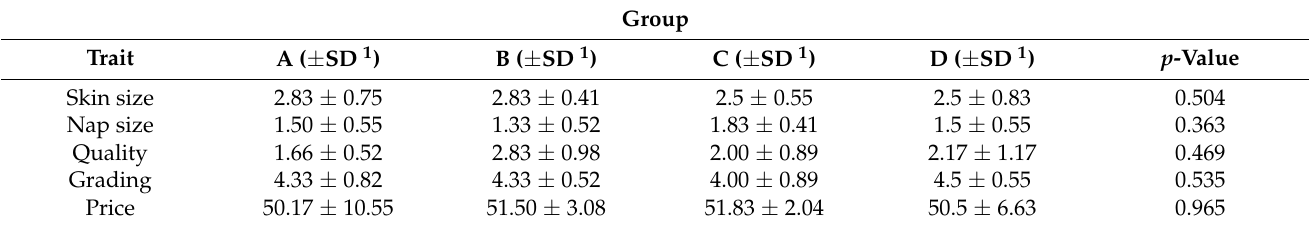
Table 5. Descriptive statistics (mean and standard deviation) for skins of male mink ( n = 6 per group). Group